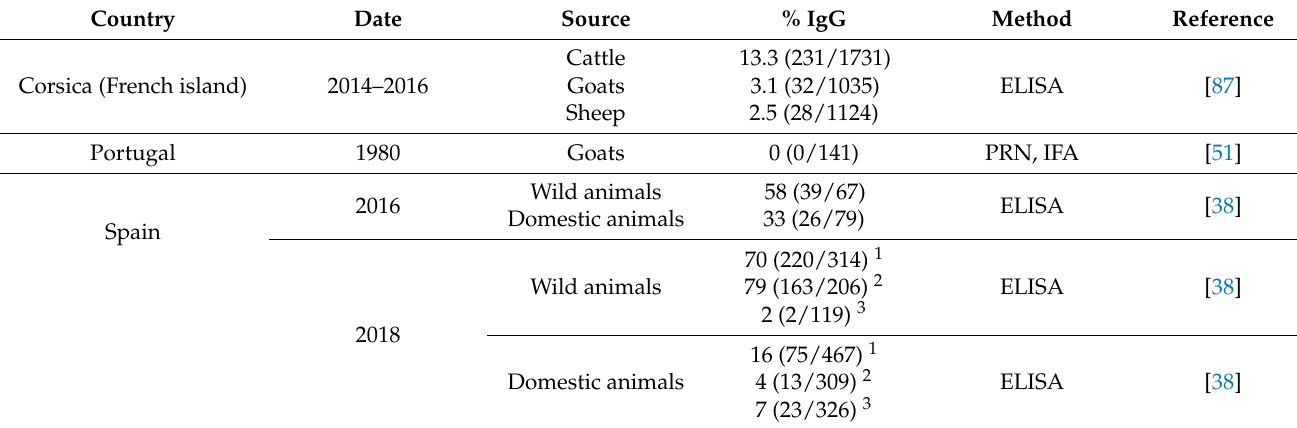
Table 5. Seroprevalence studies of Crimean Congo hemorrhagic fever virus-infected livestock in western Europe.